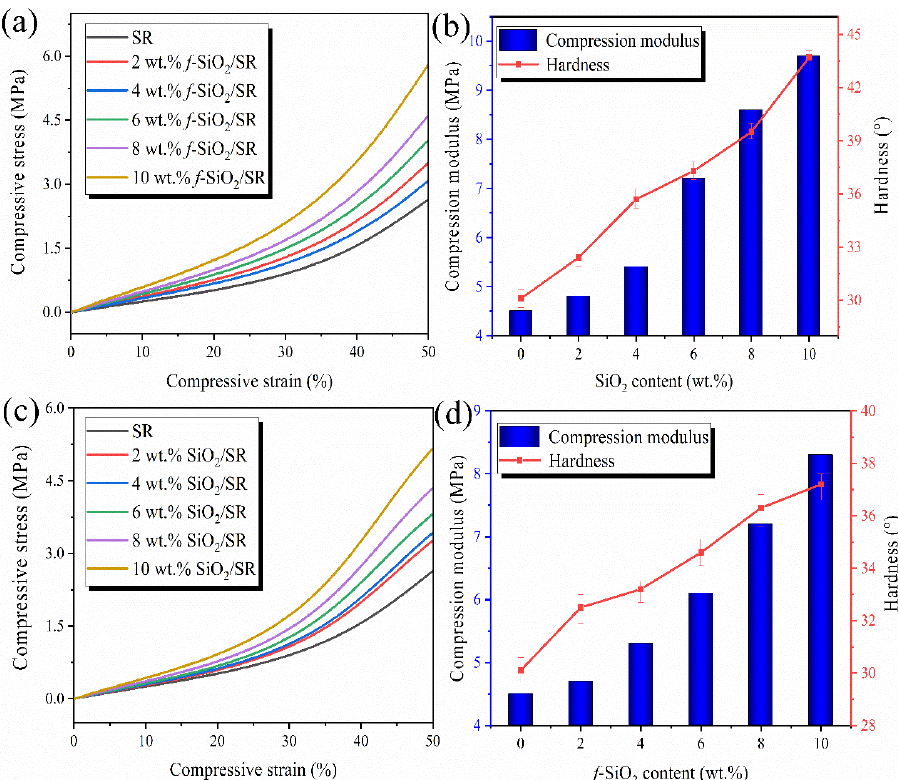
Figure 11. ( a , c ) Compressive stress–strain curves of f -SiO 2 /SR and SiO 2 /SR composites; ( b , d ) com- pressive modulus and hardness of f -SiO 2 /SR and SiO 2 /SR composites. Table 4. Comparison of Mc for SiO 2 /SR and f-SiO 2 /SR